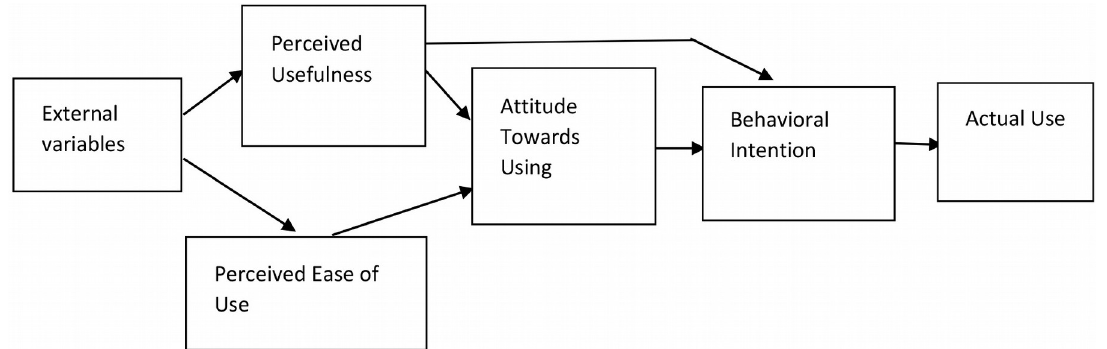
Figure 1. Technology Acceptance Model (TAM) (Based on Davis et al. 1989)